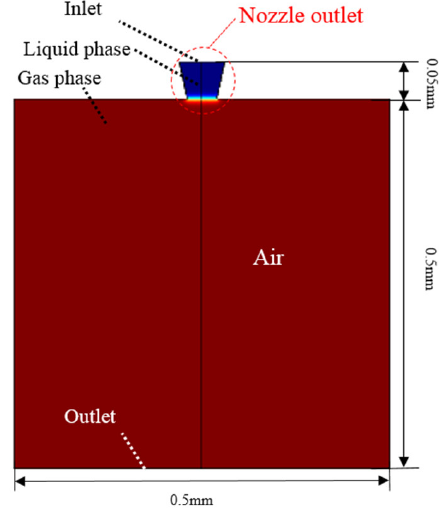
Figure 7. CFD two-phase